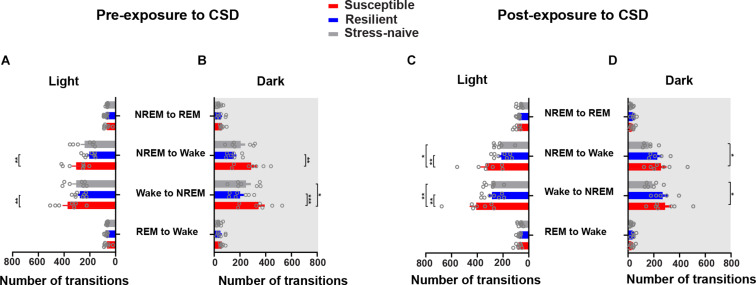
Susceptible mice displayed a higher number of state transitions between NREM and wake during the light and dark phases pre- and post-exposure to CSD. Pre-CSD: (A) The numbers of transitions from wake to NREM and from NREM to wake were higher in susceptible mice relative to resilient mice (p < 0.01 and p < 0.01, respectively) during the light. (B) In the dark, the numbers of transitions from wake to NREM and from NREM to wake were higher in susceptible mice relative to resilient (p < 0.0001 and p < 0.001, respectively) and stress-naïve mice (p < 0.05 and p = 0.066, respectively). Post-CSD:
(C) In the light, the numbers of transitions from wake to NREM and from NREM to wake were higher in susceptible mice compared to resilient (p < 0.01 and p < 0.01, respectively) and stress-naïve mice (p < 0.01 and p < 0.05, respectively). (D) In the dark, the numbers of transitions from the wake to NREM and from NREM to wake were higher in susceptible mice compared to stress-naïve mice (p < 0.05 and p < 0.05, respectively). Values are expressed as number of transitions across 12-h intervals (mean ± sem). n = 7–8 for each group. Post hoc analyses using Tukey’s multiple comparisons were performed.